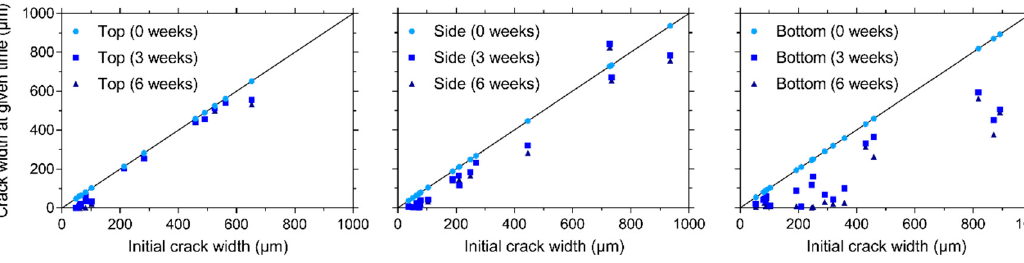
Figure11. Evolutionofthecrackwidthunderwet-dry(W / D)cyclesonthetop, side, Figure 11. Evolution of the crack width under wet-dry (W/D) cycles on the top, side, and bottom surfaces. Figure 11. Evolution of the crack width under wet-dry (W/D) cycles on the top, side, and bottom surfaces. Figure 11. Evolution of the crack width under wet-dry (W/D) cycles on the top, side, and bottom surfaces.